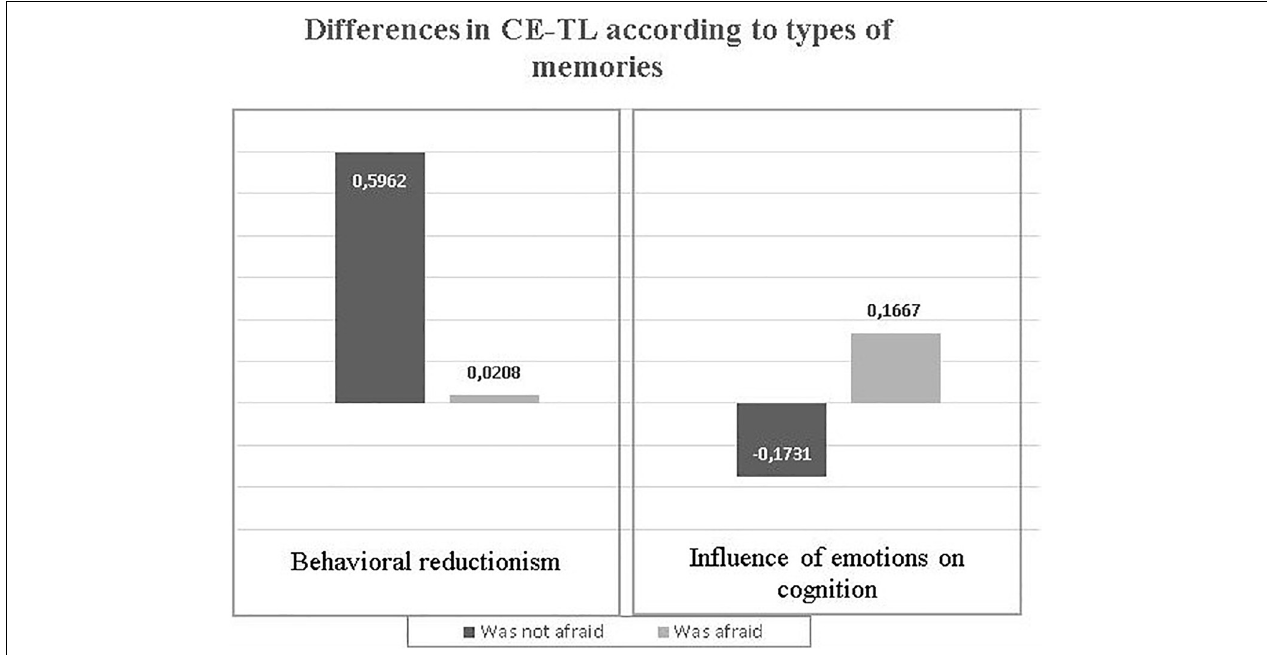
FIGURE 9 | Differences in Teachers’ Conceptions about the relationships between Emotions and Teaching and Learning processes (CE-TL) according to types of memories.